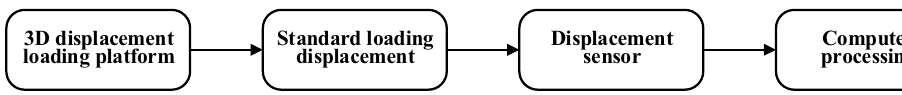
Displacement sensor